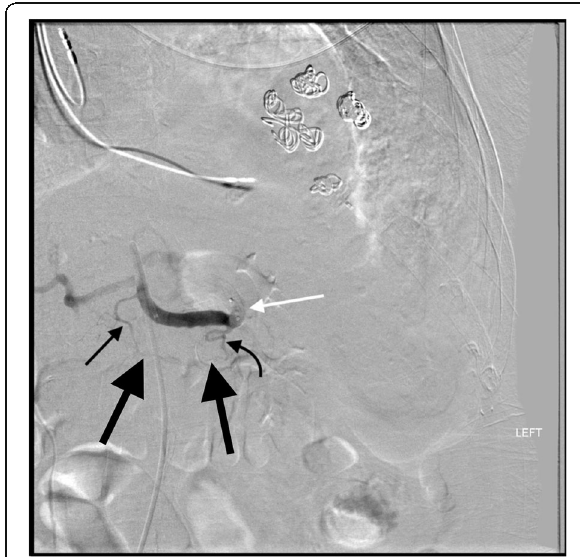
Fig. 7 85 year old male with pancreatic cancer status post iatrogenic trauma following drain placement for a perisplenic abscess. Splenic artery DSA after embolization shows that the AMPLATZER ™ Plug (white arrow) has mistakenly been placed distal to the great pancreatic artery (curved black arrow). This excludes collateral perfusion of the spleen via the dorsal pancreatic artery (straight thin black arrow) to transverse pancreatic (thick black arrows) to great pancreatic artery pathway